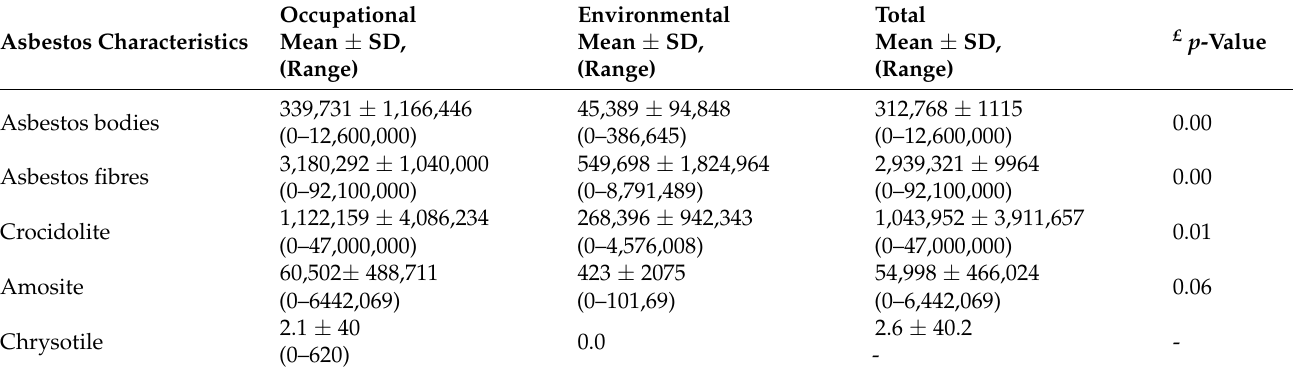
Table 6. Asbestos bodies and fibre counts by exposure type (millions per gm of dried